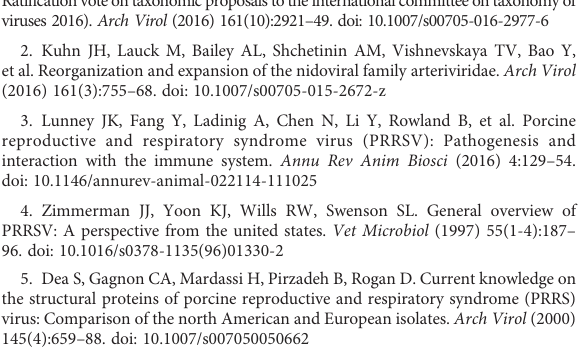
SUPPLEMENTARY FIGURE 1 Expression of recombinant pGM-CSF and screening anti-pGM-CSF monoclonal antibody. (A) Electrophoresis of pGM-CSF cDNA cloned from total cDNA reverse transcribed from total RNA isolated from LPS- stimulated PBMCs of piglet. (B) Analysis of purity for recombinant pGM- CSF expressed in E. coli . using SDS-PAGE. SUPPLEMENTARY FIGURE 2 Characterization of mAb-2A4H11 and rabbit polyclonal antibody against pGM-CSF for pGM-CSF expressed in mammalian cells. (A) BHK21 cells were transfected with pVenus-pGM-CSF plasmid for 24 hours. Then the cells were fi xed and permeabilized before antibodies staining using mAb- 2A4H11 and an isotype control mAb. Interaction between mAb with corresponding target was visualized by secondary antibodies. (B) BHK21 cells were transfected with pVenus-pGM-CSF or empty vector for 24 hours. Then the cells were harvested for SDS-PAGE followed by western blotting assay use mAb-2A4H11, GFP-speci fi c-mAb and puri fi ed pGM- CSF rabbit polyclonal antibody to con fi rm the